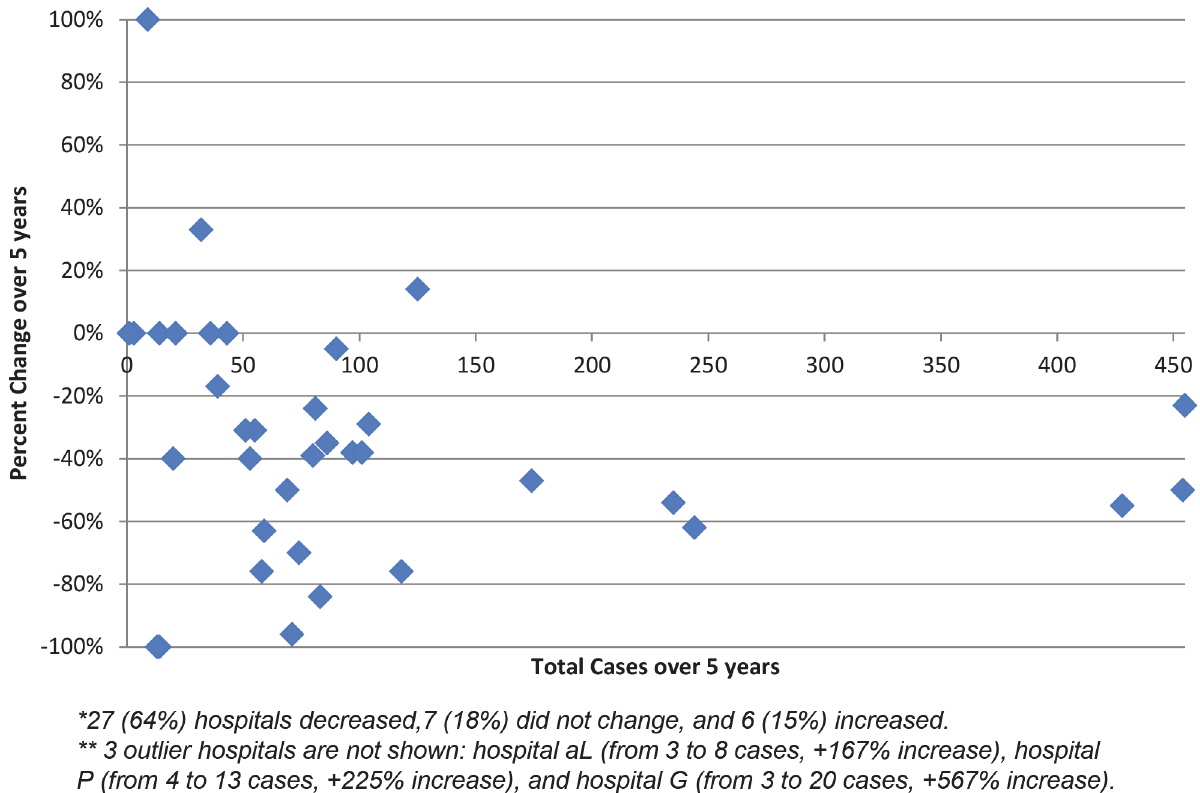
Fig 4. Changes in candidemia case count at participating hospitals over the five-year study period (2008 – 2013), by the total number of cases each hospital contributed during the study.